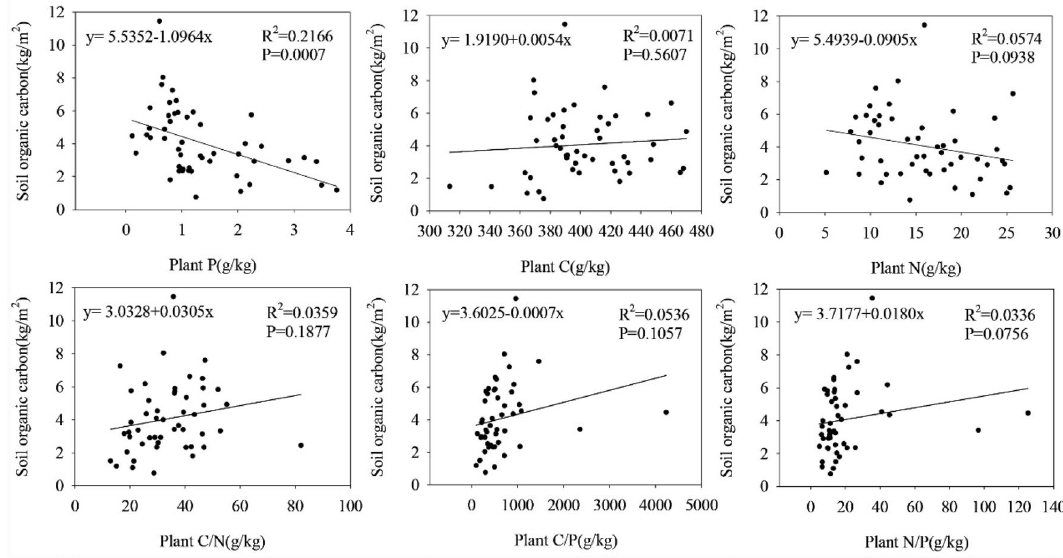
Figure 4. Determine the soil organic carbon density (SOCD, kg·m −2 ) and plant nutrient factor content under each sample, and correlate the soil organic carbon density (SOCD, kg·m −2 ) with Plant P (g·kg −1 ), Plant C, Plant N, Plant C/N, Plant C/P, and Plant N/P in the same space.